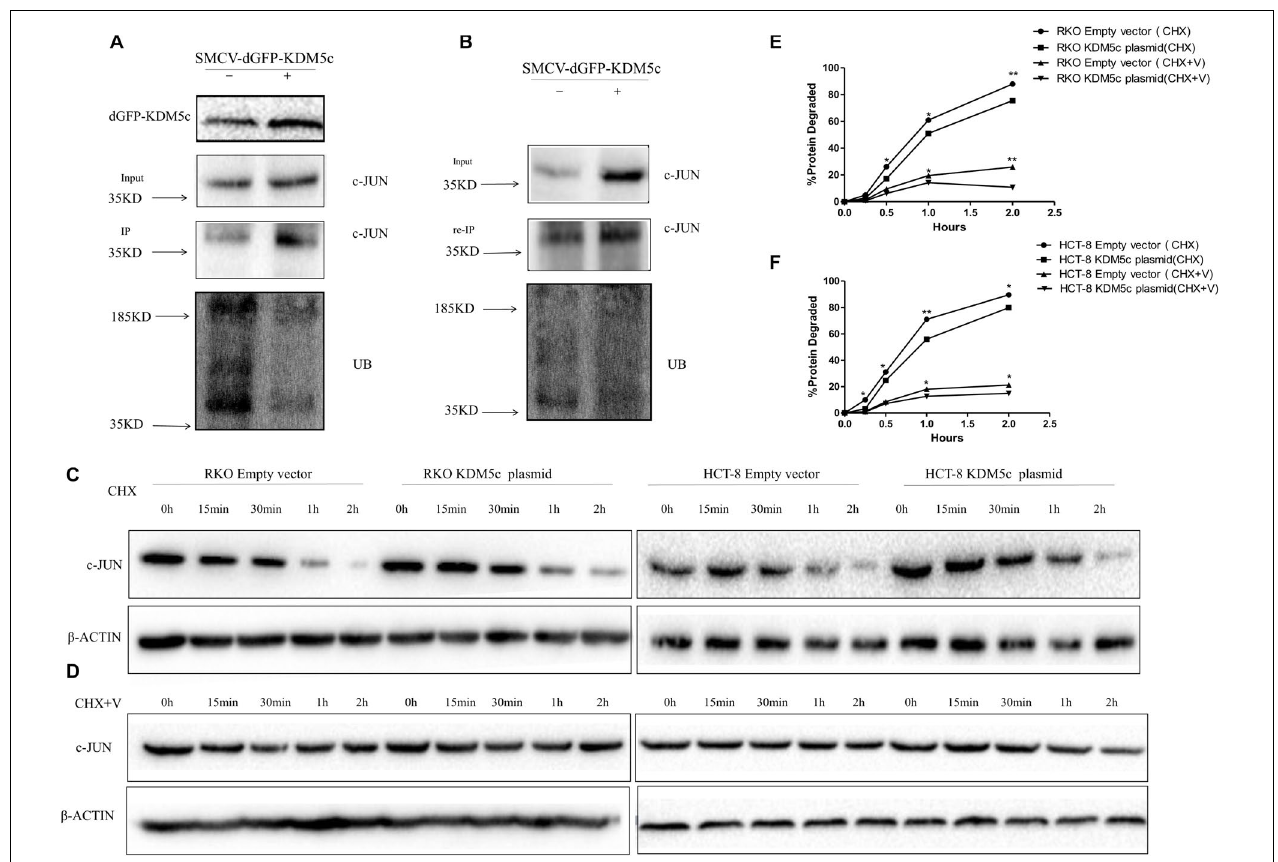
FIGURE 5 | KDM5c reduces proteasome-mediated c-Jun degradation. (A) KDM5c reduces the ubiquitination of c-Jun in vivo . RKO cells were transfected with an empty vector or vector encoding KDM5c-dGFP. After immunoprecipitation of c-Jun from lysates, the levels of c-Jun and ubiquitinated c-Jun were determined by Western blot using antibodies against c-Jun or Ub. (B) Re-immunoprecipitation of the ubiquitinated c-Jun. After the ubiquitination assay performed as in (A) , the proteins were eluted from the beads using SDS sample buffer, re-incubated with antic-c-Jun antibody, and then c-Jun ubiquitination was detected as in (A) . (C) Time course of c-Jun loss in either RKO or HCT-8 cells. Cells transfected with either the empty vector or KDM5cOE were treated with cycloheximide (CHX) (100 ug/ml) to inhibit protein biosynthesis before examination. The level of β -Actin was detected as the loading control. (D) Time course of c-Jun loss in the same cells as in (C) after the combined treatment of proteasome inhibitor VELCADE and CHX. Cells were first treated by 100 nM VELCADE for 12 h, then combined with 5 mg/ml CHX for another 2 h. β -Actin was detected as the loading control. (E,F) Quantitation of Western blots. Bands corresponding to c-Jun got from RKO (E)